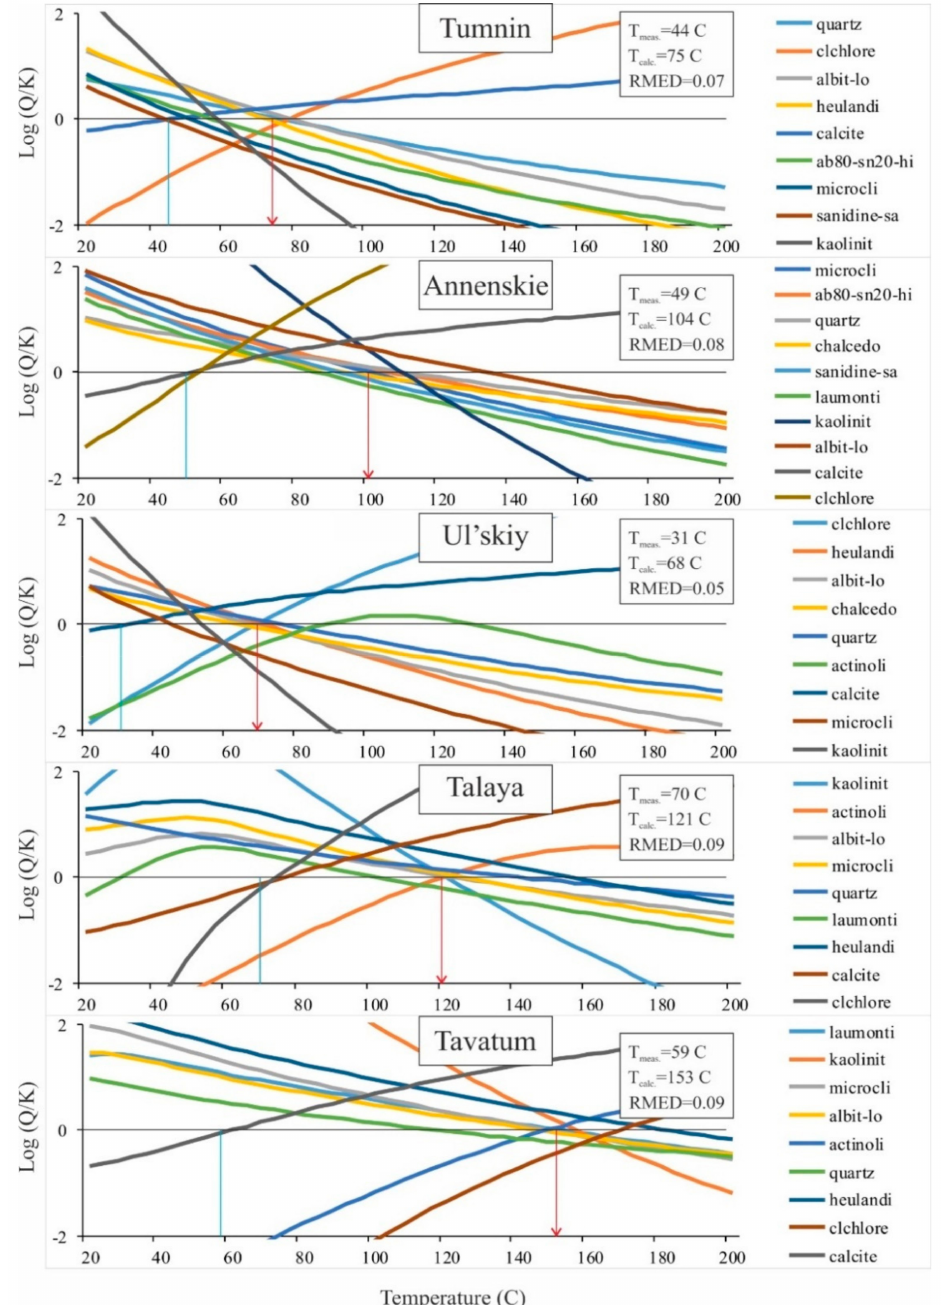
Figure 6. Computed saturation indices, log(Q/K), as a function of temperature for studied thermal waters. RMED- statistical analyses of saturation indices median of absolute log(Q/K) values. The reservoir temperature is inferred from the temperature at which RMED is